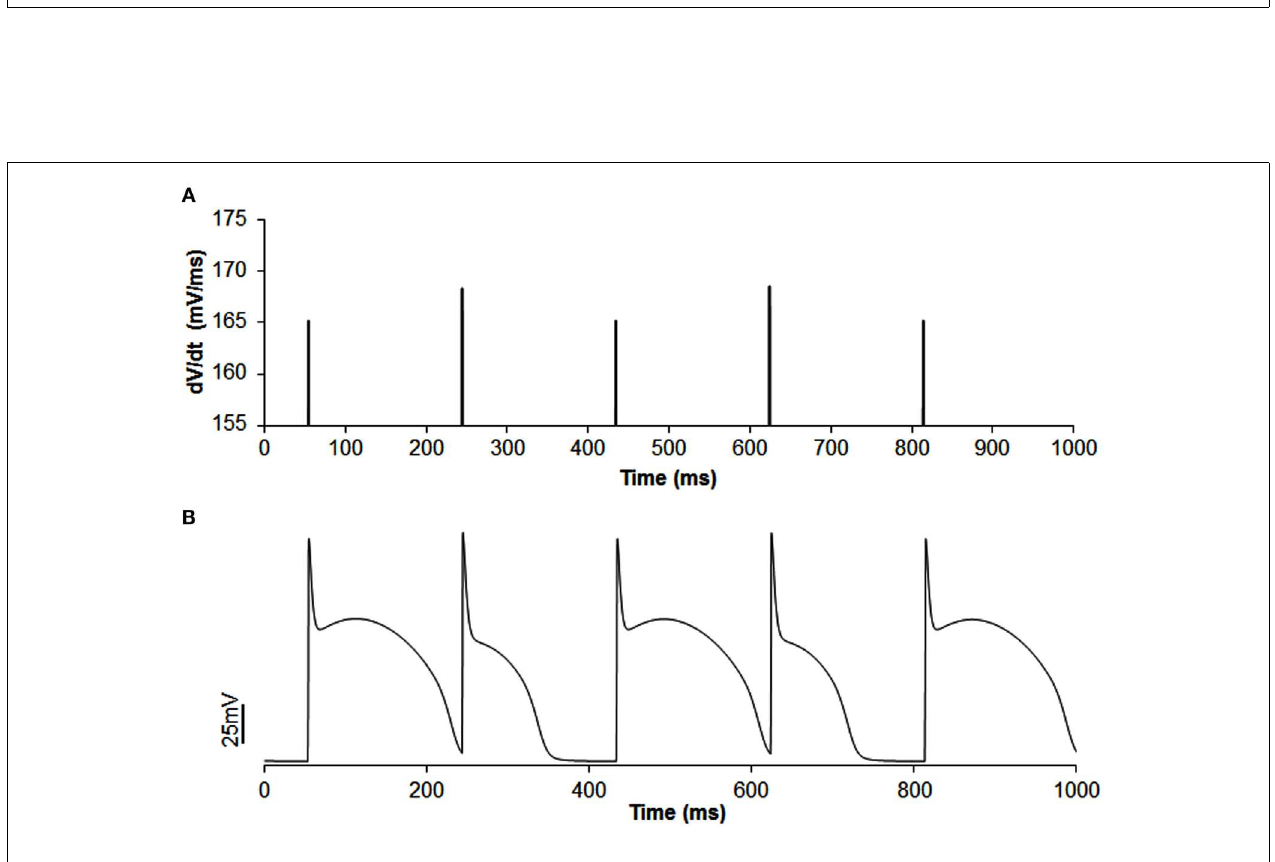
FIGUREA3 | Example of out of phase |d v /d t | max alternans (A) withAPD alternans (B) in single cell simulation. In this simulation, the slow inactivation gate j of sodium current was set to 1 and concentration of extracellular potassium ([K + ] o ) was